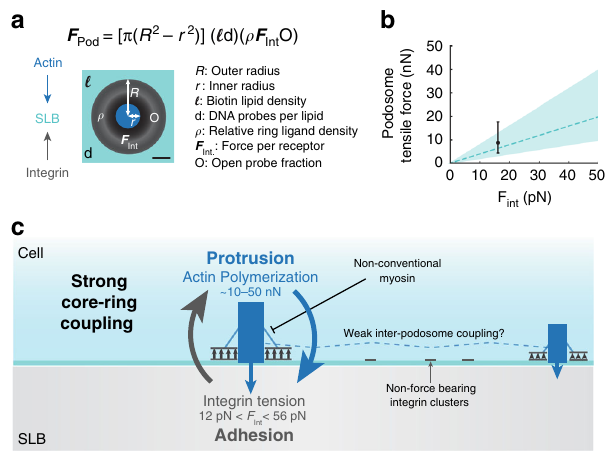
Fig. 7 Podosome ring modeling estimates nN tensile forces. a Schematic and equation for modeled podosome tensile forces on an SLB. Modeled podosome consist of a 1 μ m outer radius and a 0.3 μ m inner radius. The actin core exerts protrusion forces on the SLB, and the integrin receptors in the adhesion ring apply tensile forces. Modeled podosomes were parameterized using data from Fig. 2 and Supplementary Fig. 18. Scale bar, 2.5 μ m. b Plot of ring tensile forces as a function of the per receptor force, F Int . The dashed line indicates total tensile forces assuming 1 probe per biotinylated lipid, and the black data point represents the minimum force predicted by MT-FLIM. Con fi dence intervals and error bars correspond to 0.5 to 2 probes per biotinylated lipid. c Model of podosome forces on an SLB. Individual podosomes exert protrusion forces on the SLB with the actin core, while integrin receptors tug on RGD ligands in the ring